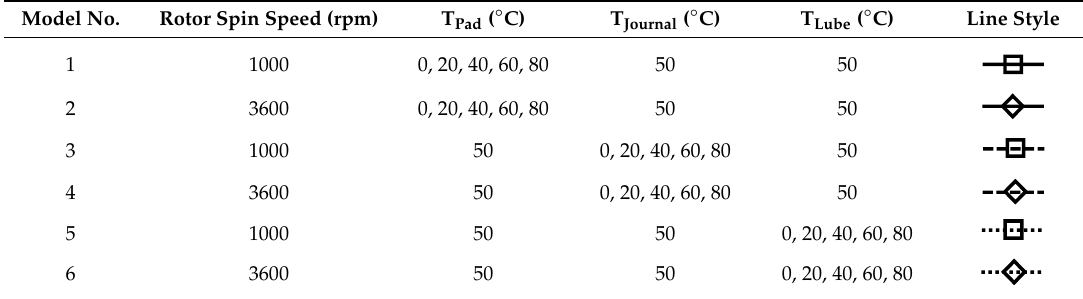
Figure 8. Thermal boundary conditions around bearing-lubricant-shaft numerical model: ( a ) cross- section view; ( b ) side view.